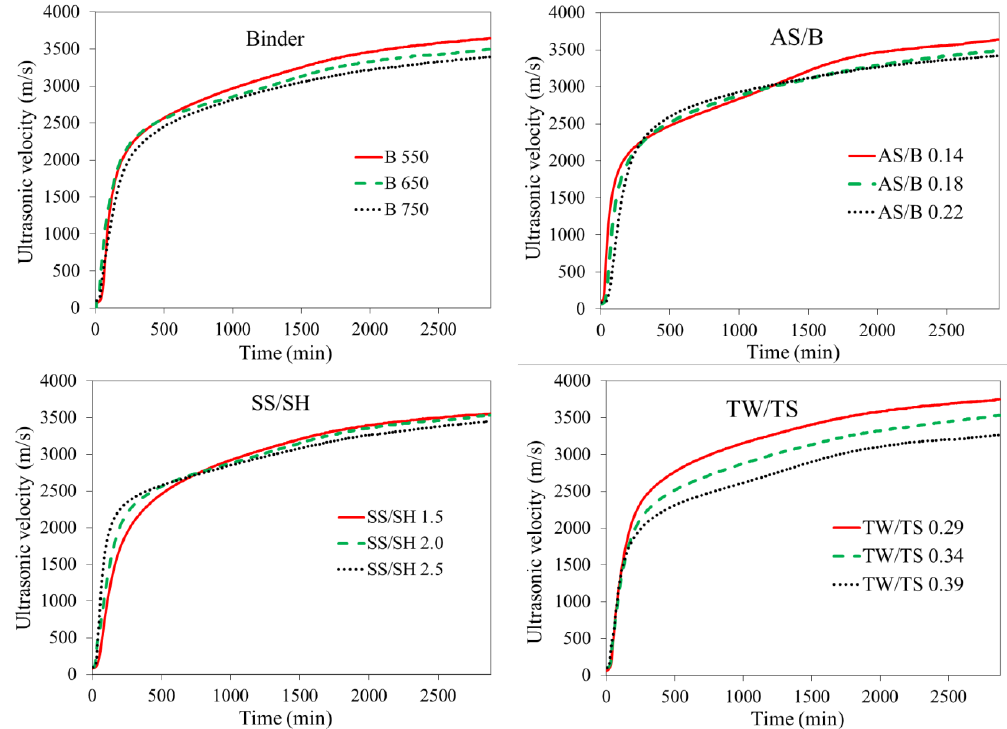
Figure 9. Effect of parameters on ultrasonic velocity.